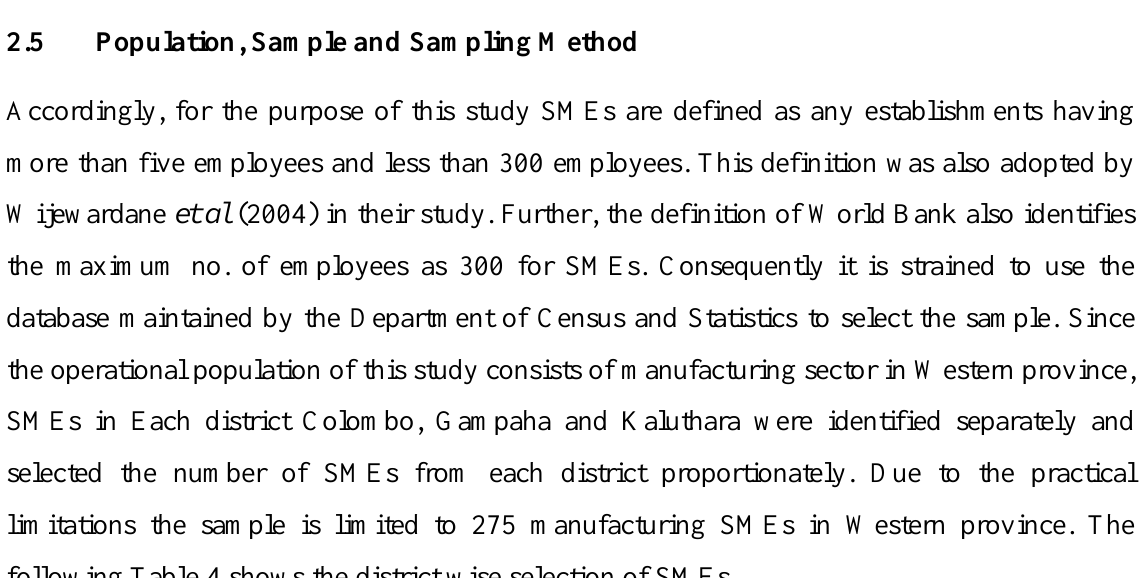
Table 4: Distribution of the Sample District (A) Population (No. of SMEs)